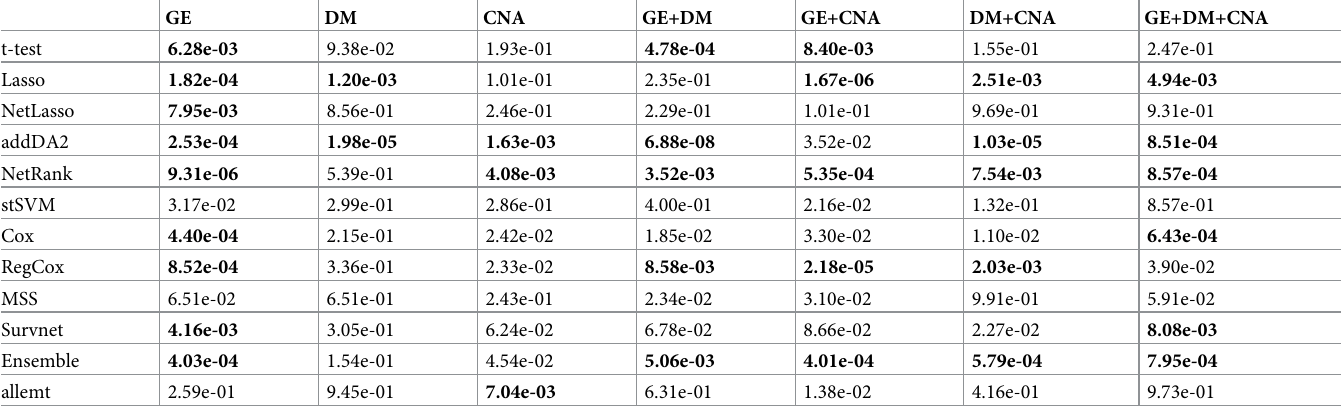
Table 7. The results of log-rank tests on stratified sample clusters using single- and multi-omics EMT signatures on early-stage samples. K-means algorithm was employed for clustering the samples into 3 groups. We highlighted all p-values that are lower than 10e-2. GE DM CNA GE+DM